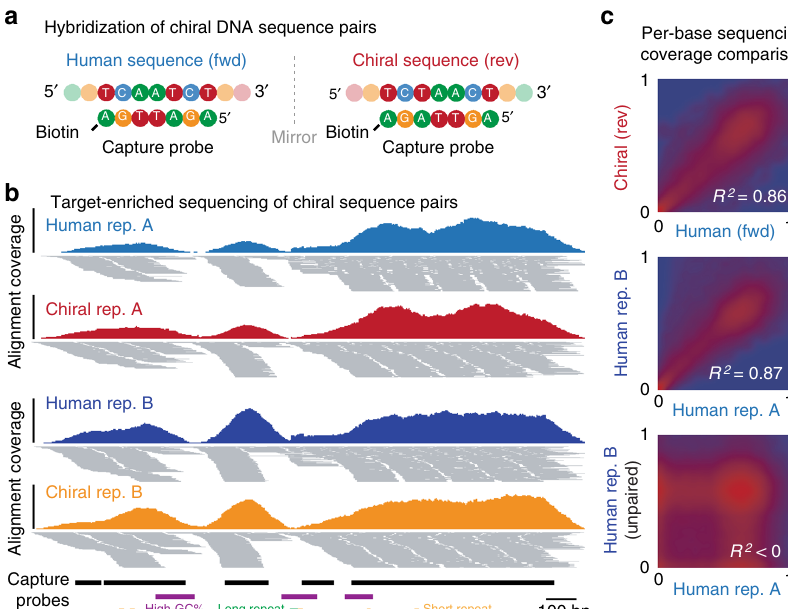
Fig. 3 Matched performance of chiral DNA sequence pairs during target-enriched NGS. a Schematic shows hybridization of a human DNA sequence to a labeled oligonucleotide probe (left) and hybridization of its chiral partner sequence to a mirrored oligonucleotide probe (right). This illustrates how human/ chiral sequence pairs are captured via mirrored hybridization interactions. b Genome browser view shows alignments from duplicate target-enriched NGS experiments analyzing a human DNA sample (blue, navy) with synthetic chiral sequences (red, orange) added. Targeted genome regions and sequence features are indicated below. c Density scatter plots show the concordance of per-base coverage pro fi les for paired human/chiral regions (upper). For comparison, the concordance of identical human/human sequences (middle) and unpaired human/human sequences (lower) between